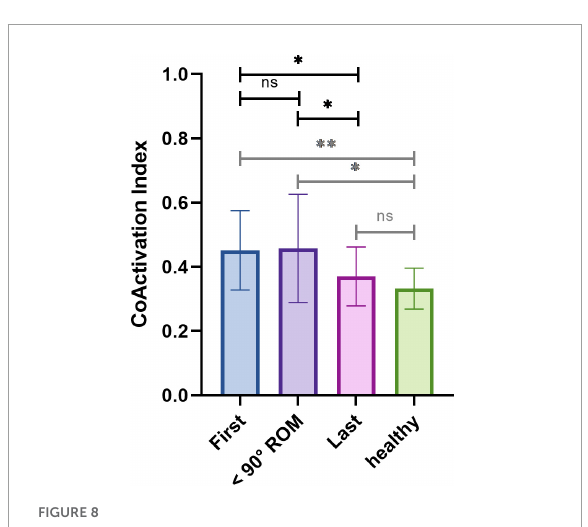
FIGURE8 Averaged coactivation index of deltoid and trapezius for the first three sessions, the three sessions preceding the reaching of the 90 degrees ROM and the last three sessions of patients, and of healthy participants.